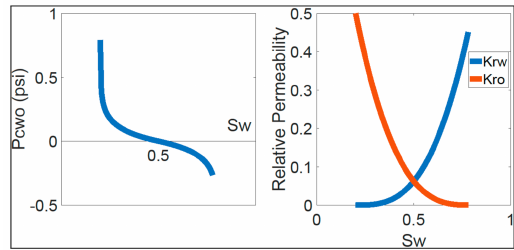
Figure 5. Water saturation functions for verification case.